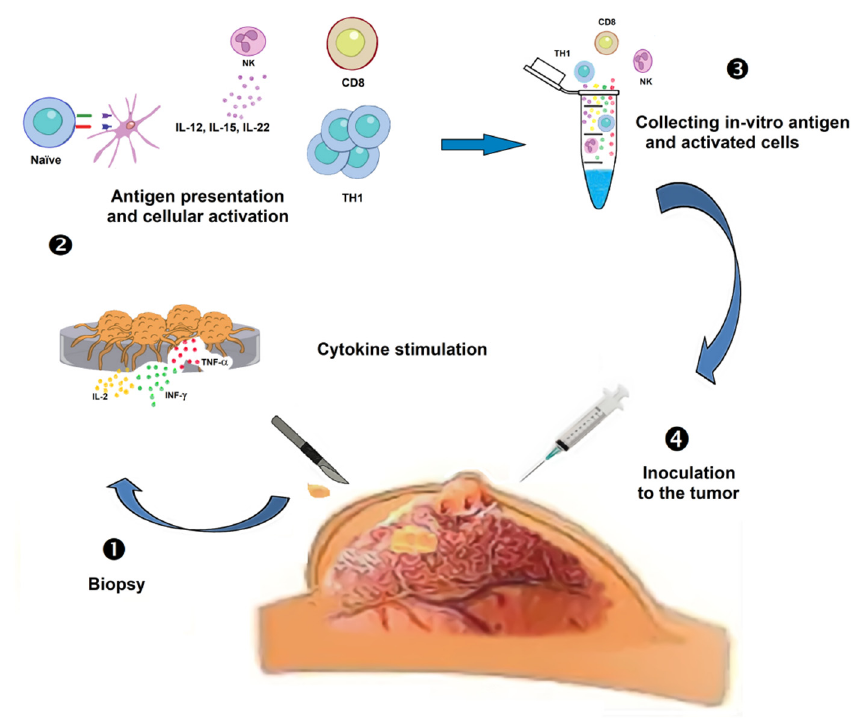
Figure 4. Response activation.